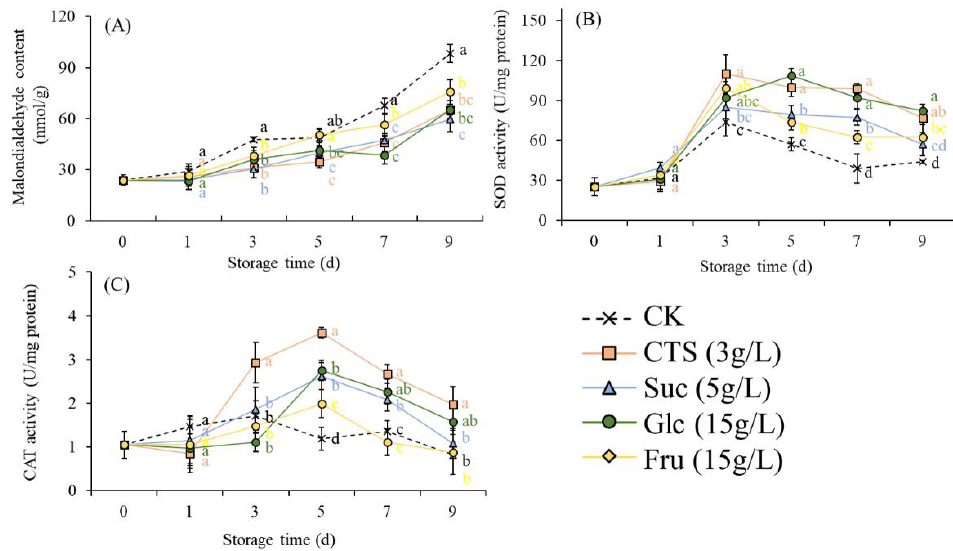
Figure 7. Effects of chitosan (3 g/L), sucrose (5 g/L), glucose (15 g/L), and fructose (15 g/L) on the ( A ) malondialdehyde content, ( B ) SOD activity, and ( C ) CAT activity of strawberry fruits stored at 15 ± 2 °C for 9 d. CK represents that strawberry fruits were immersed with water before storage. Data are mean of three replicates. Different letters in the same storage time indicate a significant difference (Tukey’s HSD test, p < 0.05). CTS, chitosan; Suc, sucrose; Glc, glucose; Fru, fructose; SOD, superoxide dismutase; CAT, catalase.